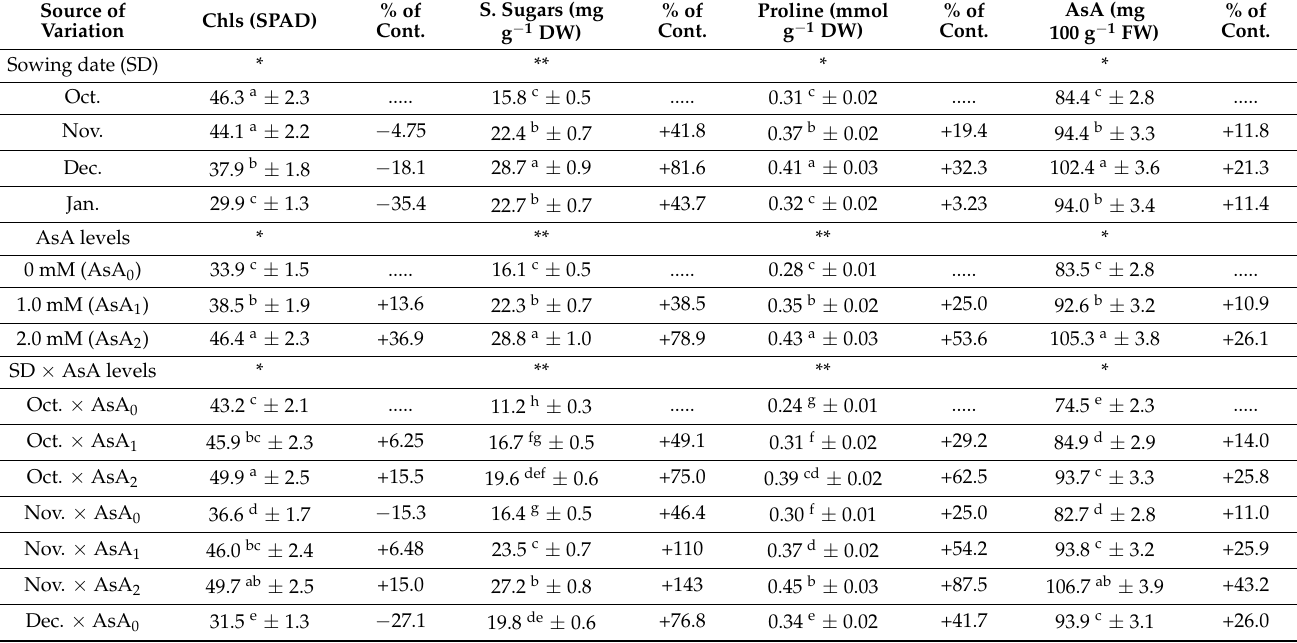
Table 5. Effect of integrative treatment of seeds and leaves with ascorbic acid (AsA) on chlorophyll, total soluble sugar, and antioxidant (AsA: vitamin C and proline) contents of parsley plants